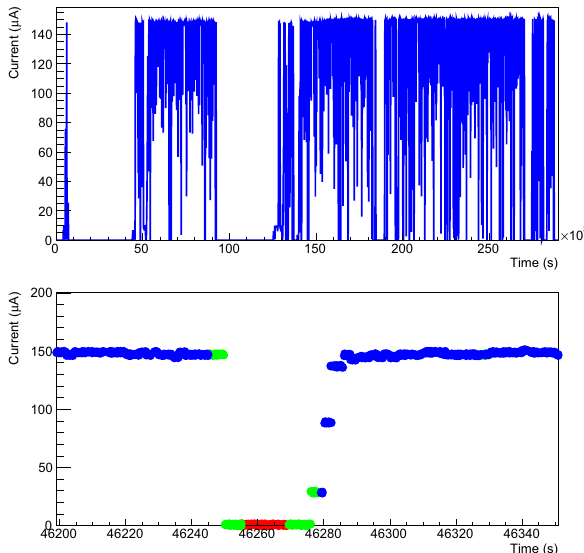
Fig. 12 Top panel shows an example of the beam current as a function of time. Bottom panel shows a zoom of a short period: the blue points represent the beam on periods, the red ones are the beam-off periods and the green ones are the periods excluded from the data analysis – see text for more